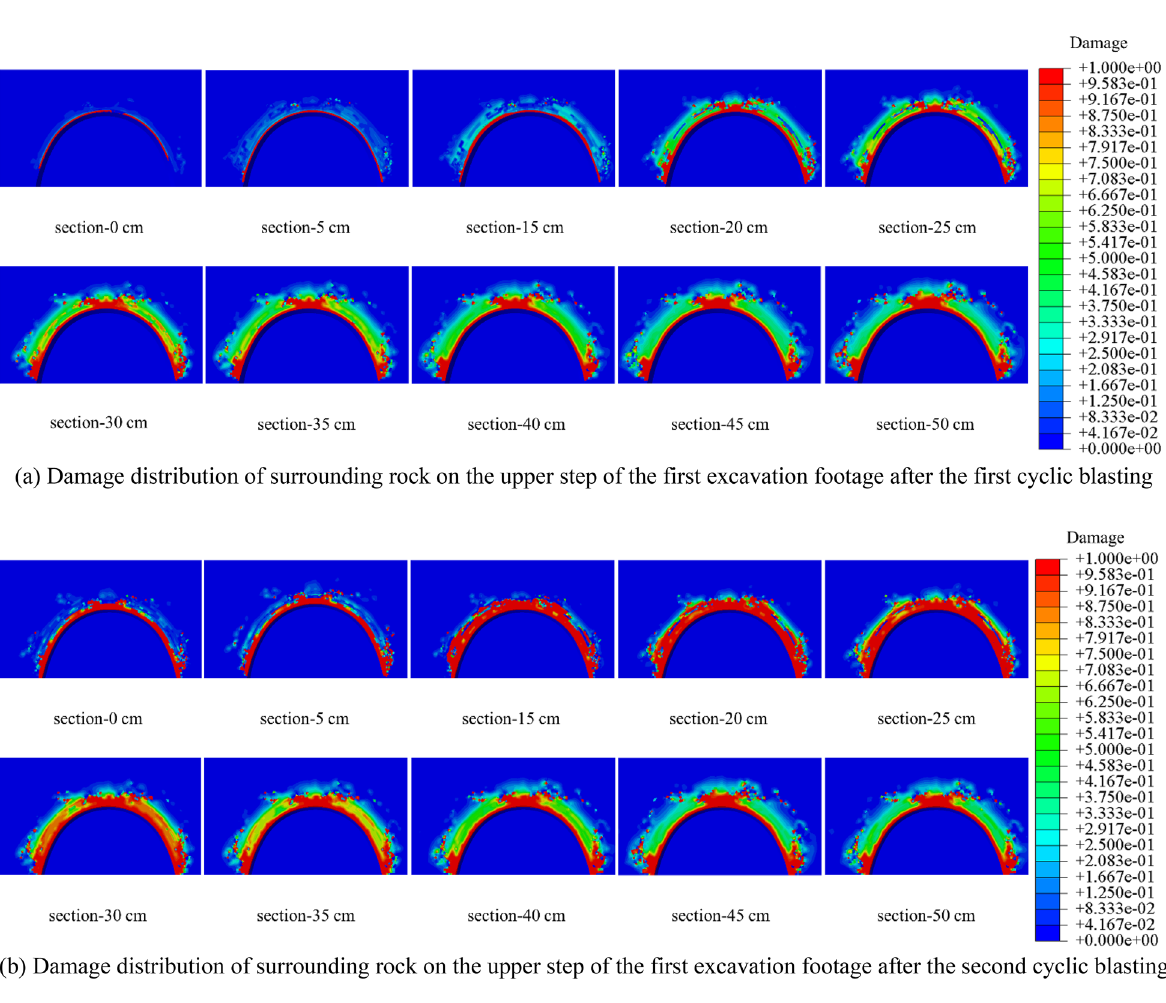
Figure 14. Damage distribution of surrounding rock in different sections of the upper step of the first excavation